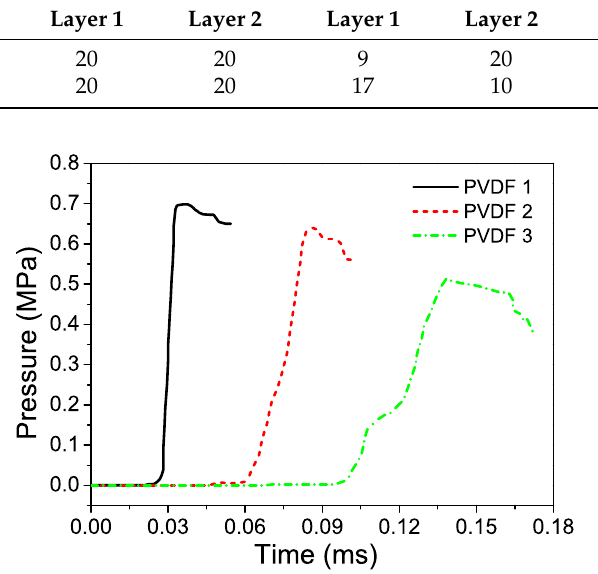
Figure 5. Pressure–time histories in positive aluminum foam specimen (test 1). PVDF 1 was sandwiched between an upper steel plate and layer 1; PVDF 2 was sandwiched between layer 1 and layer 2; PVDF 3 was sandwiched between layer 2 and the distal steel plate. Table 3. Deformation dimensions of deformed specimens.